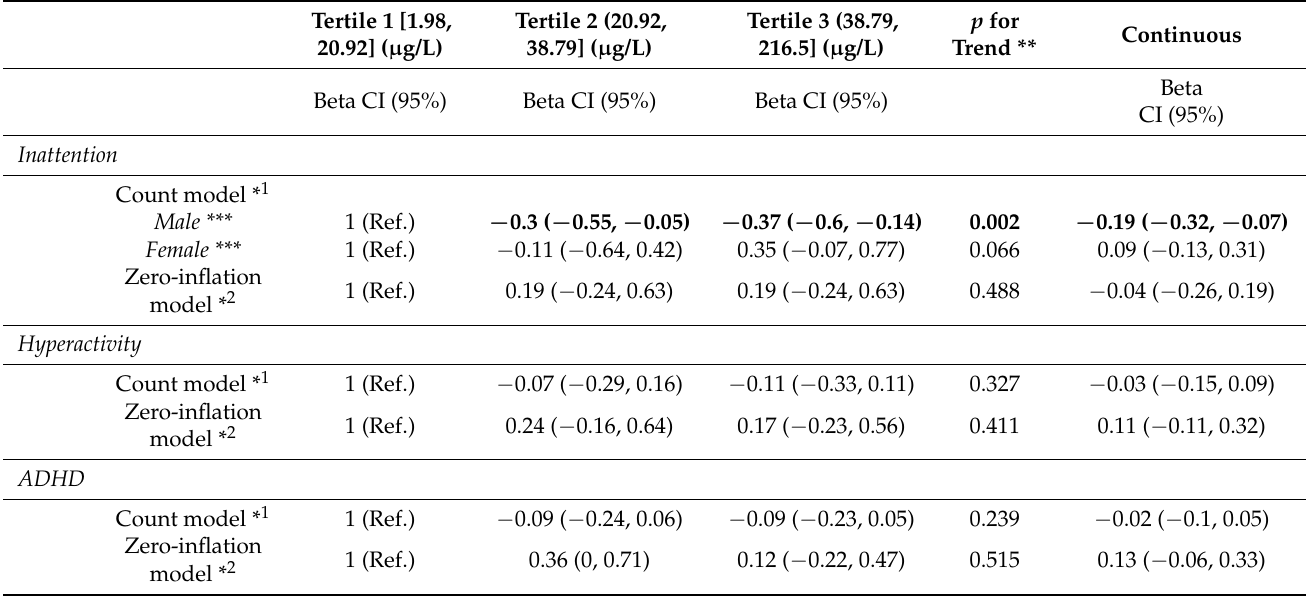
Table 3. Zero-inflated Poisson regression models for the association between inattention, hyperactivity, and ADHD symptoms with ferritin levels ( µ g/L log scale) on a continuous scale and in